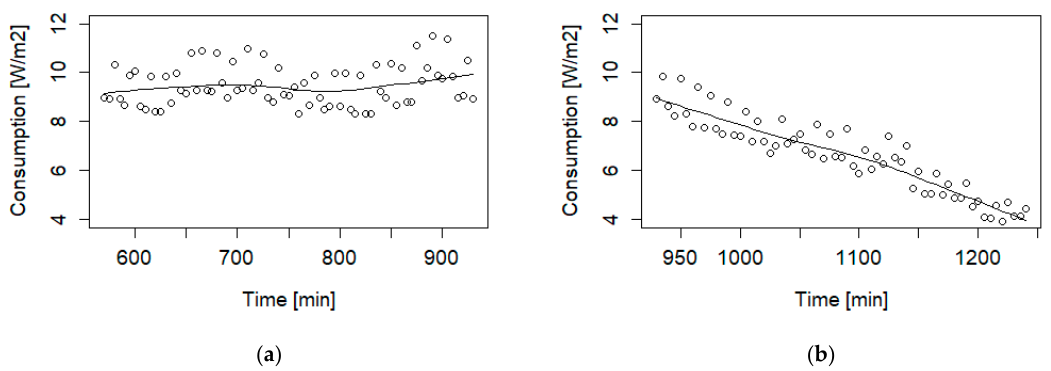
Figure 5. Scatter plots: ( a ) Daytime period 09:30-15:30; ( b ) Off-work period 15:30–22:00.